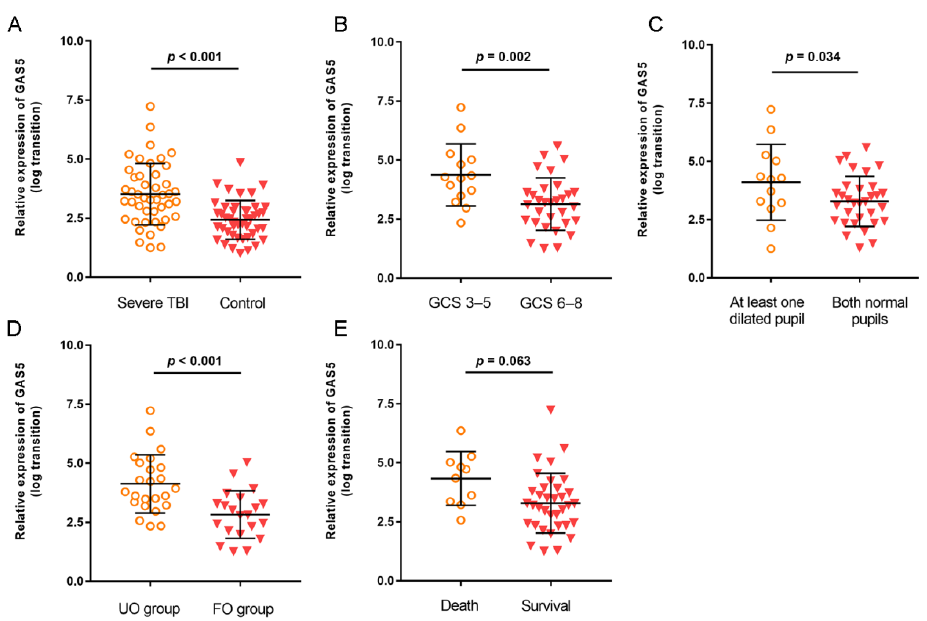
Figure 1. The relative levels of GAS5 in plasma samples of severe TBI patients and controls catego- rized by clinical variables: ( A ) severe TBI versus control; ( B ) GCS 3 – 5 versus GCS 6 – 8; ( C ) at least one dilated pupil versus both normal pupils; ( D ) unfavorable outcome (UO) group versus favorable outcome (FO) group; ( E ) death versus survival. Expression of GAS5 was expressed relative to its respective level of cel-miR-39. The bar represents mean and standard deviation.